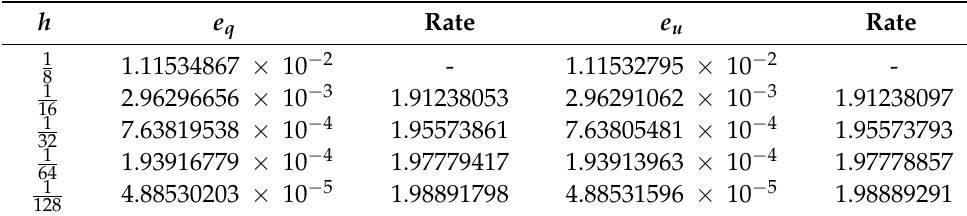
Table 7. Error e q and e u for the spatial convergence rates with α = 0.3.